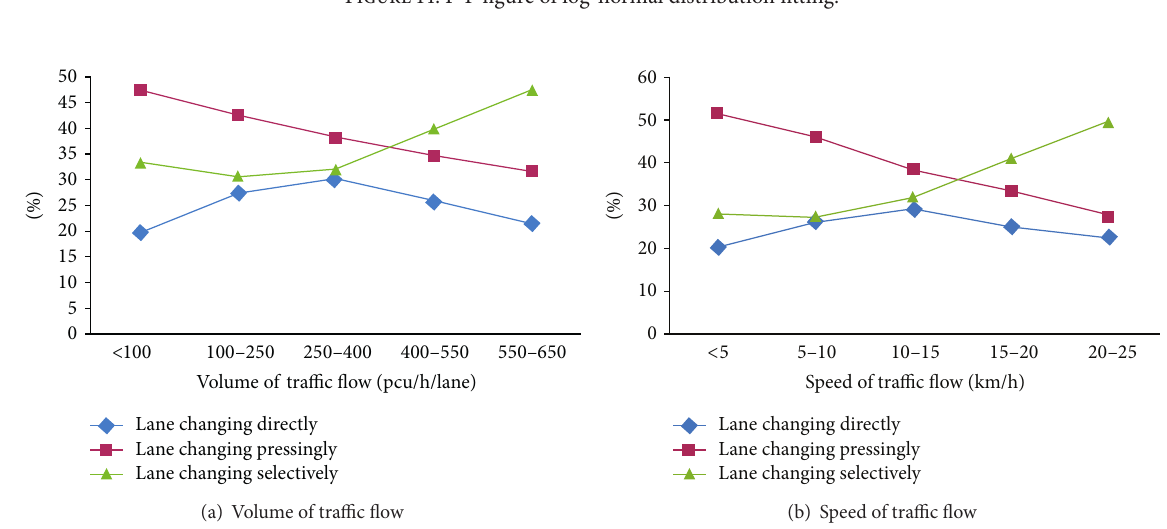
Figure 15: Average weight of different risky lane changing behaviors in typical cities of